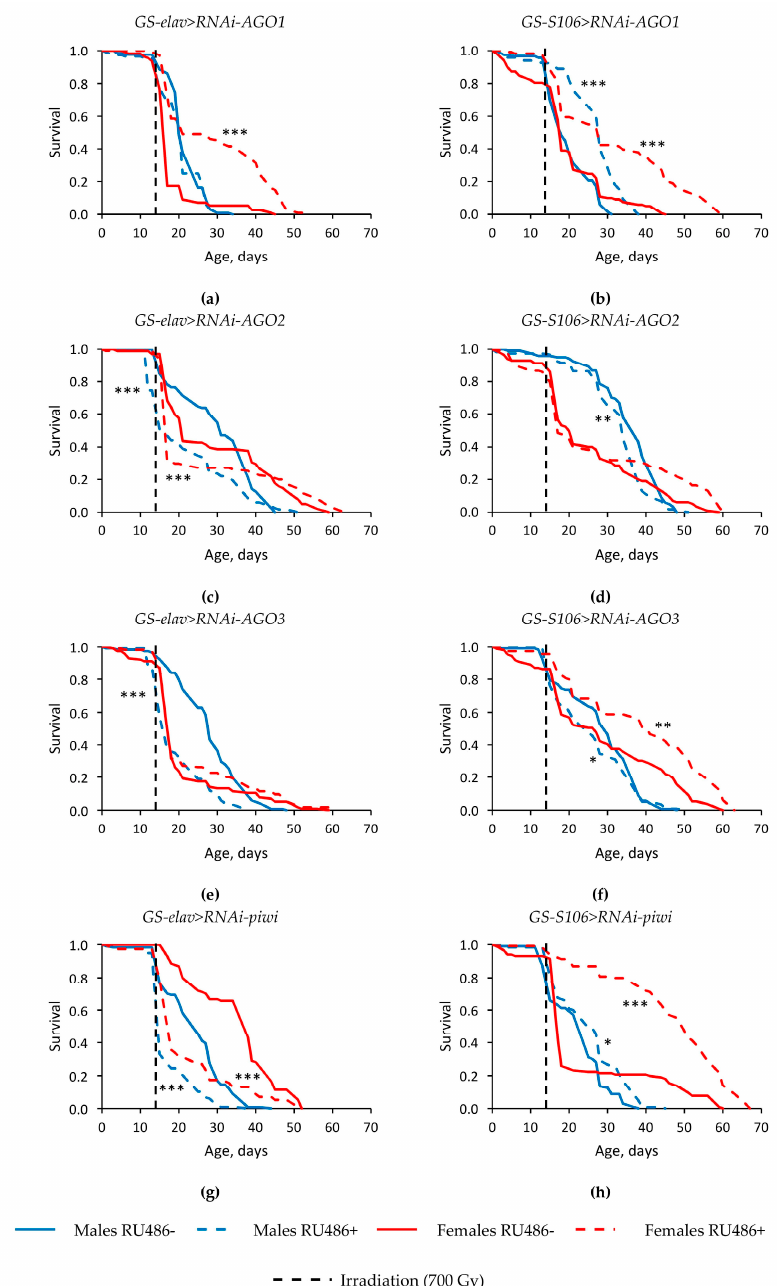
Figure 3. Influence of AGO1 ( a , b ), AGO2 ( c , d ), AGO3 ( e , f ), piwi ( g , h ) knockdown in the nervous system ( a , c , e , g ) and fat body ( b , d , f , h ) on the survival of Drosophila flies after γ -irradiation at the dose of 700 Gy. Differences between survival of flies curves with Argonaute knockdown (RU486+) and without knockdown (RU486-) are statistically significant with * p < 0.05, ** p < 0.01, *** p < 0.001 (Kolmogorov–Smirnov test).